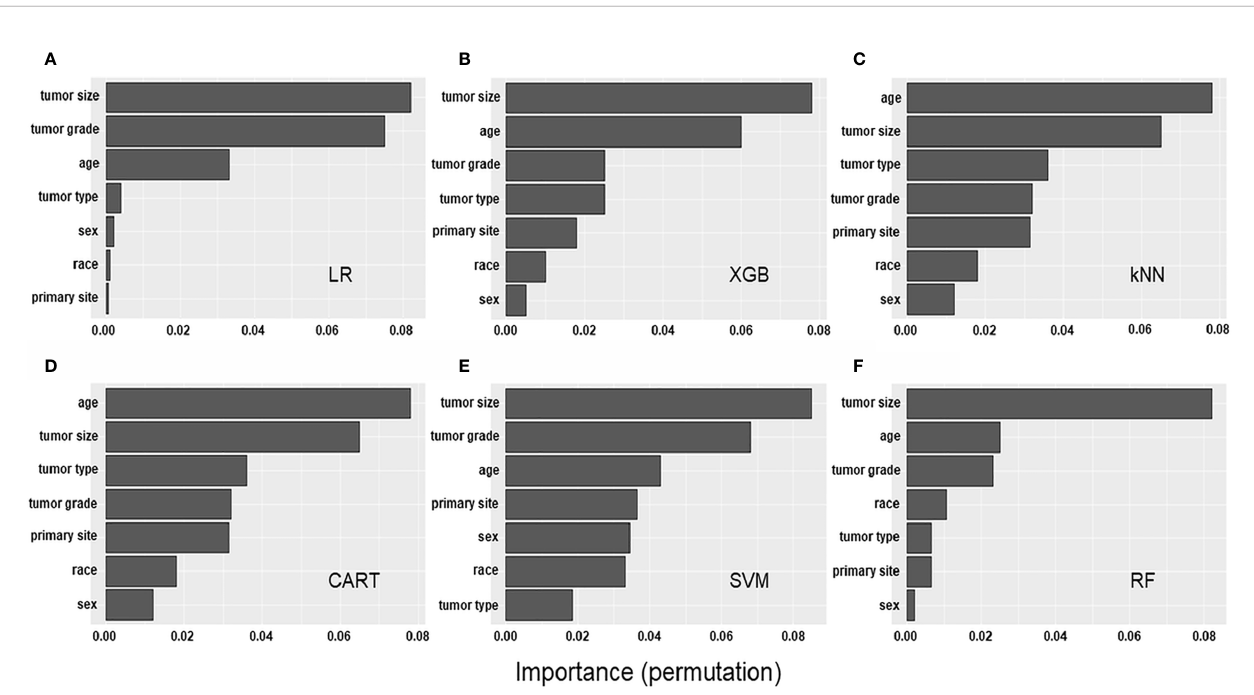
FIGURE 3 | Factor importance of the developed models. The (A – F) Bar graphs describe the proportion of importance of the different predictors in the